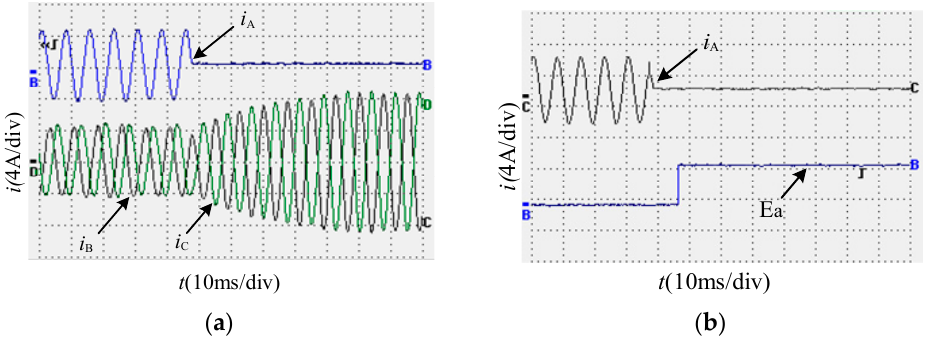
Figure 28. Phase current and fault index waveform in case of phase failure of phase a : ( a ) fault current waveform; ( b ) fault phase current and fault index waveform.